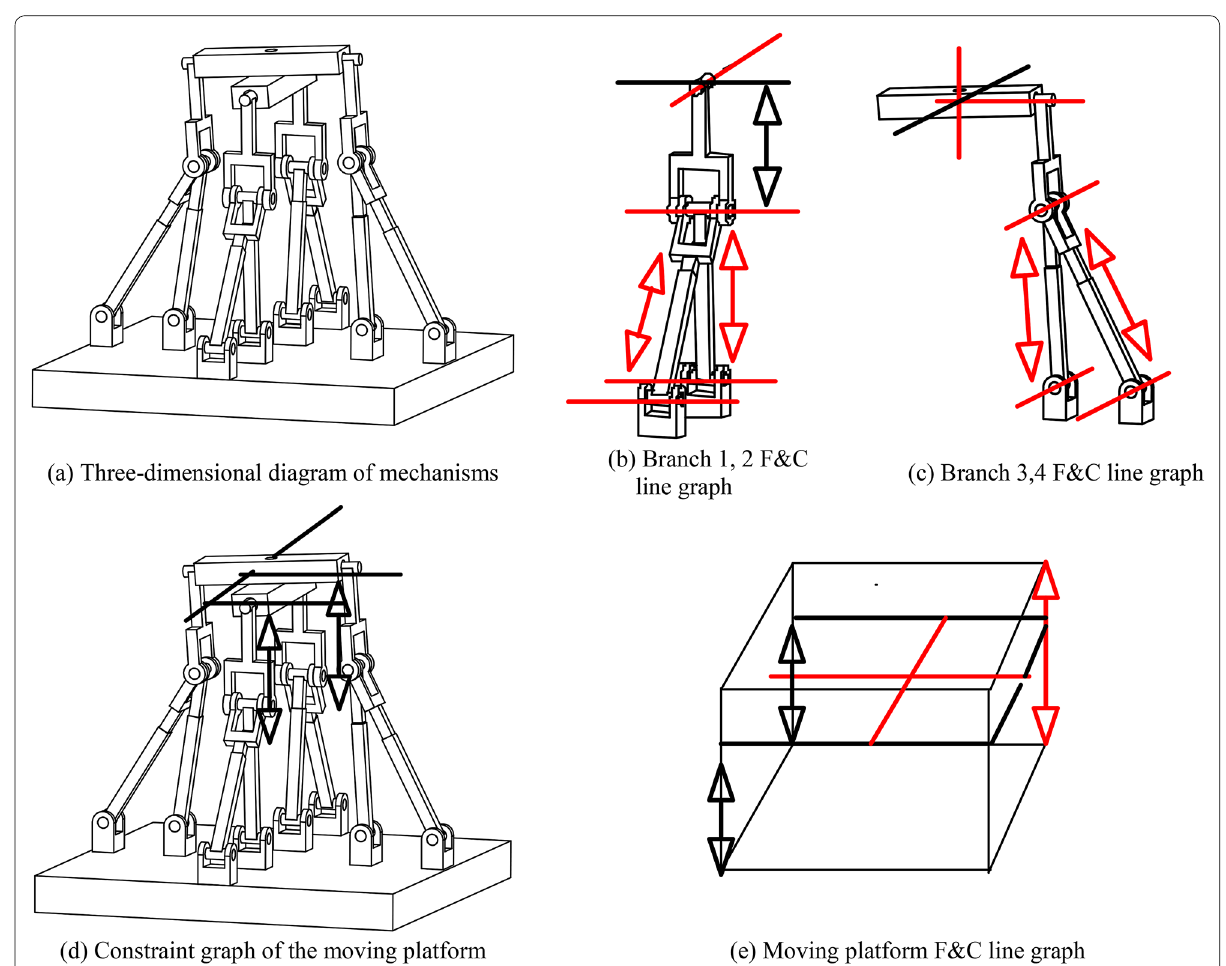
Figure 8 Correlated line diagram at initial